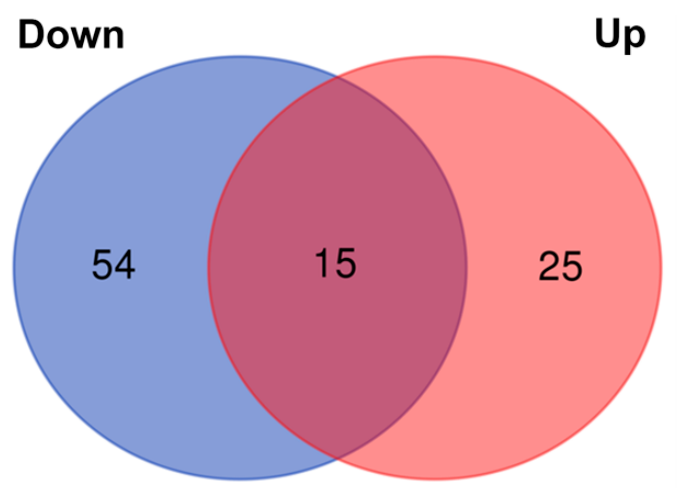
Figure 1. Venn diagram representing the differentially expressed proteins between control and METH+oxy groups.